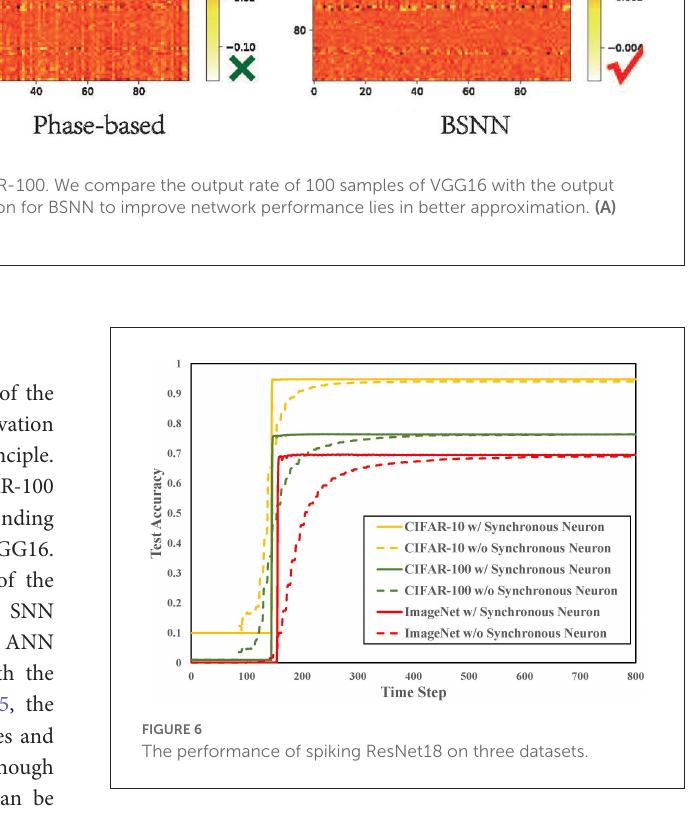
TABLE 2 The results of adding synchronous neurons on